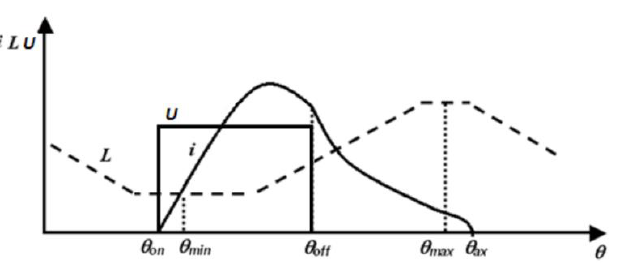
Figure 12. One-pulse control. The waveform of current i , voltage U ( PWM ), and Phase inductance L of the SRM motor as a function of the position of the angle of the rotor poles in relation to the stator poles φ [30].